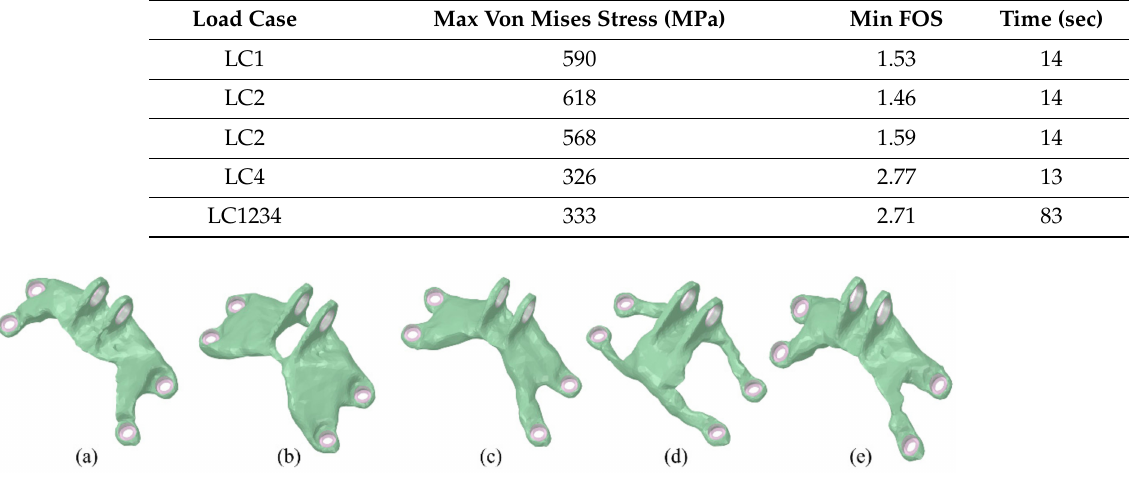
Figure 7. The best T -solutions in each load case and at all load cases: ( a ) LC1, ( b ) LC2, ( c ) LC3, ( d ) LC4, and ( e ) LC1234. Table 2. The results of the validation studies of the TO of the macroscale